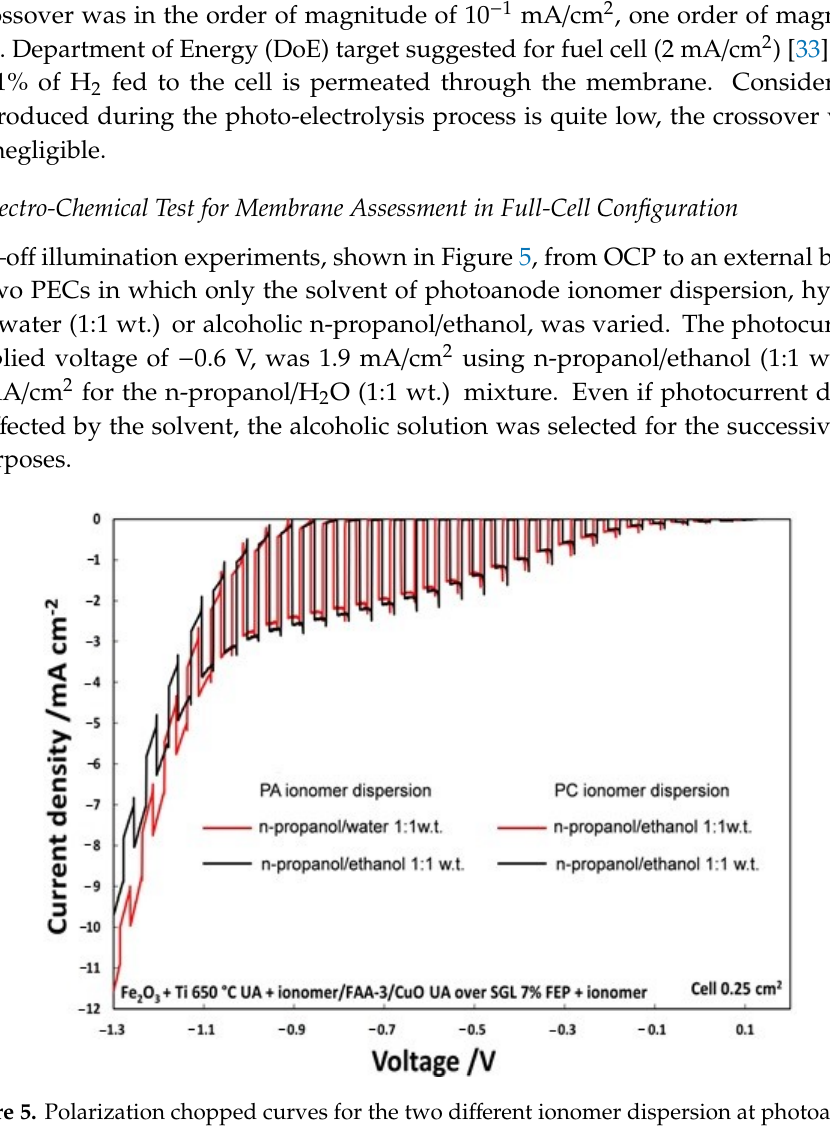
Figure 6. ( a ) On–off polarization curves by varying ionomer loading at photoanode; ( b ) efficiency versus photoanode ionomer loading. A similar trend was shown for the on–off polarization (Figure 7a) and consequently for the efficiency (Figure 7b) of PECs in which the influence of different ionomer loading on the photocathode (10, 25 and 40 µL cm − 2 ) was evaluated keeping constant at 25 µL cm − 2 the photoanode ionomer content.